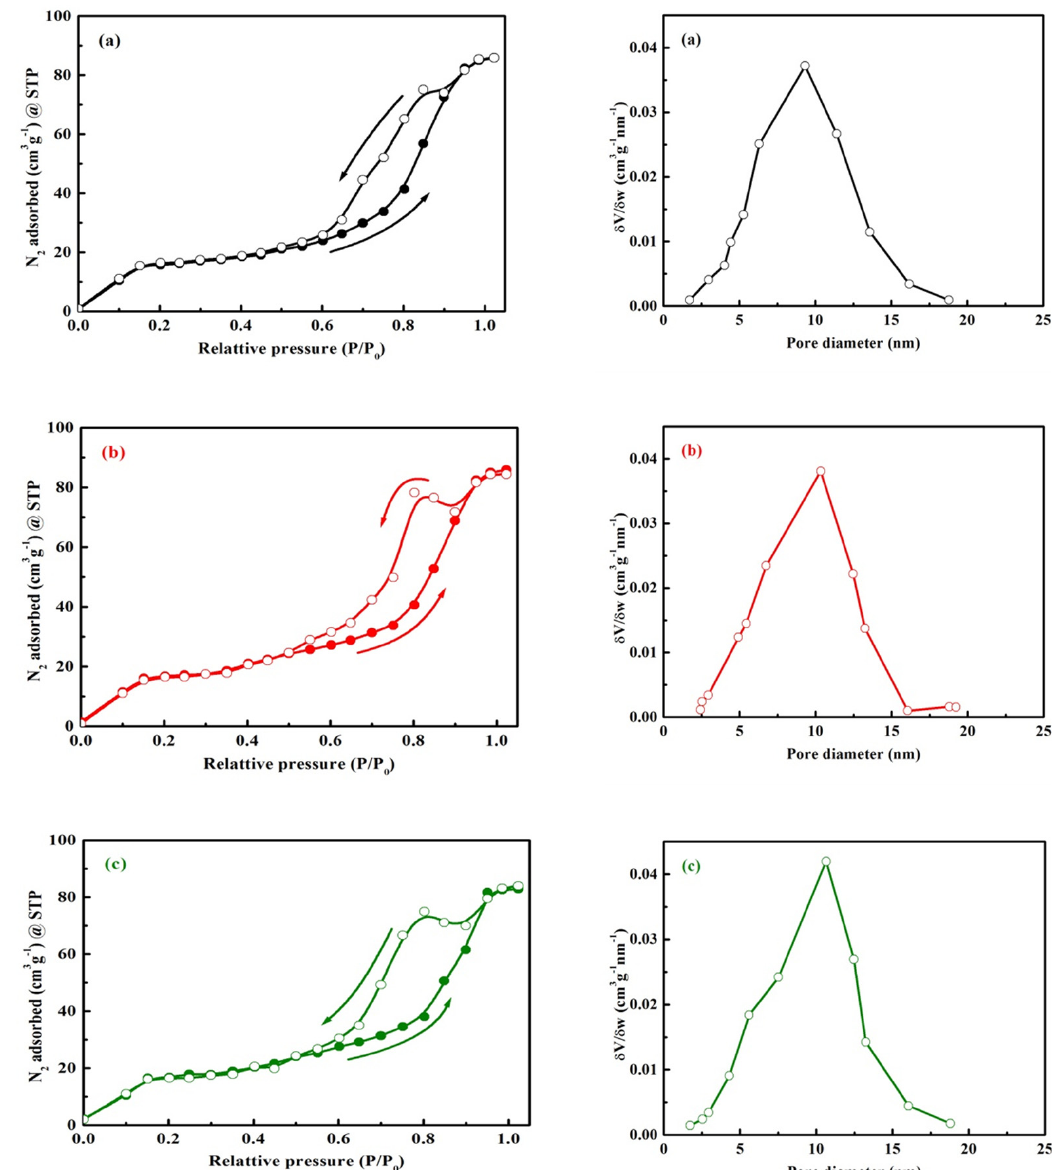
Figure 6. N 2 adsorption ‐ desorption isotherms ( left ) and pore size distribution curves ( right ) of BiFeVOx.y for ( a ) y = 0.03, ( b ) y = 0.07, and ( c ) y = 0.15. Table 3. Specific surface characteristics and dye adsorption efficiencies of BiFeVOx.y photocatalyst series.